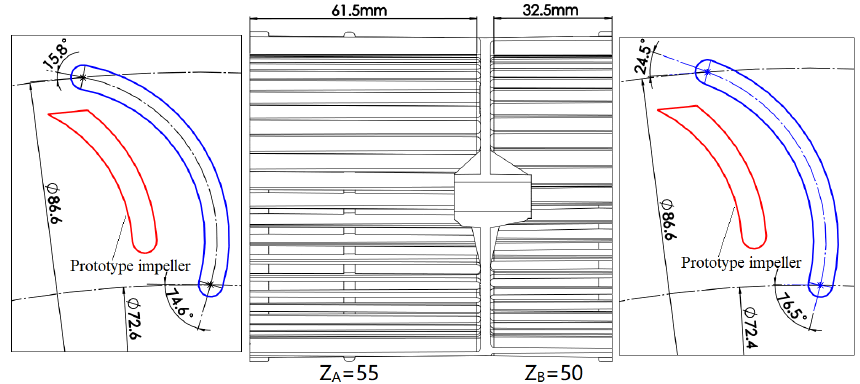
Figure 20. Comparison of prototype and optimal fan’s impeller blade profile.